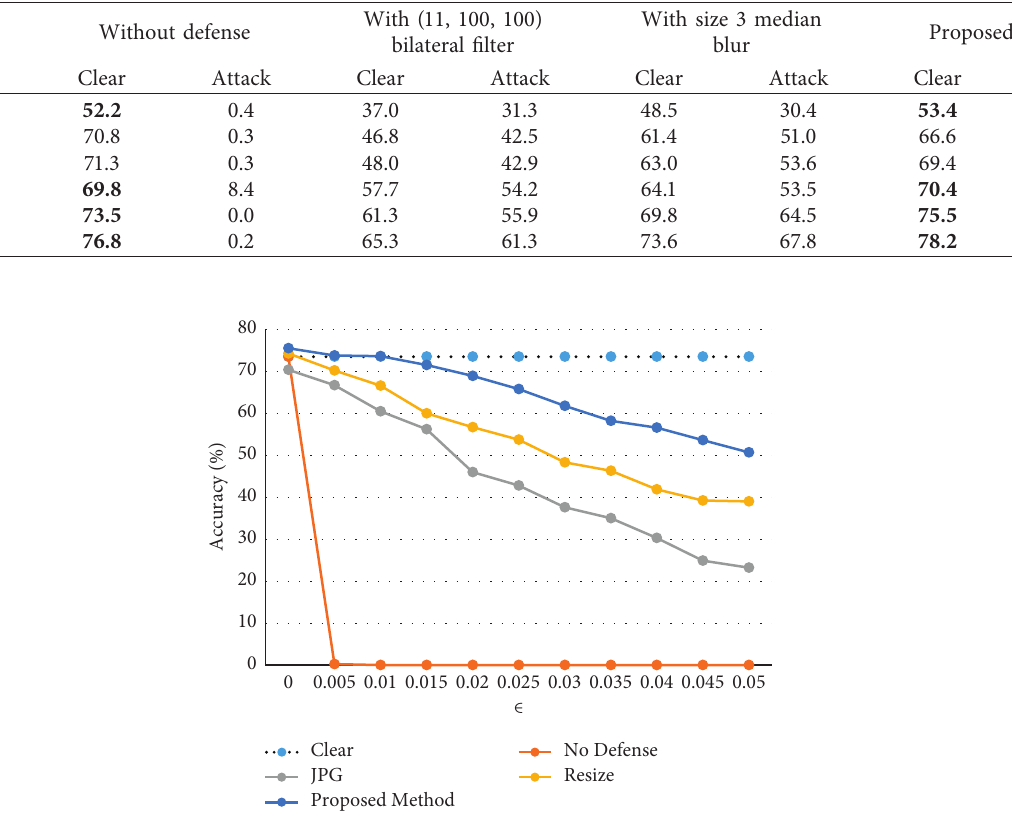
Figure 6: The comparison of our work with JPG compression [18] and randomization [19] (ResNet-50 top-1 accuracy under I-FGSM Table 2: Top-1 accuracy (%) under FGSM, DeepFool, and C&W attacks. Target model